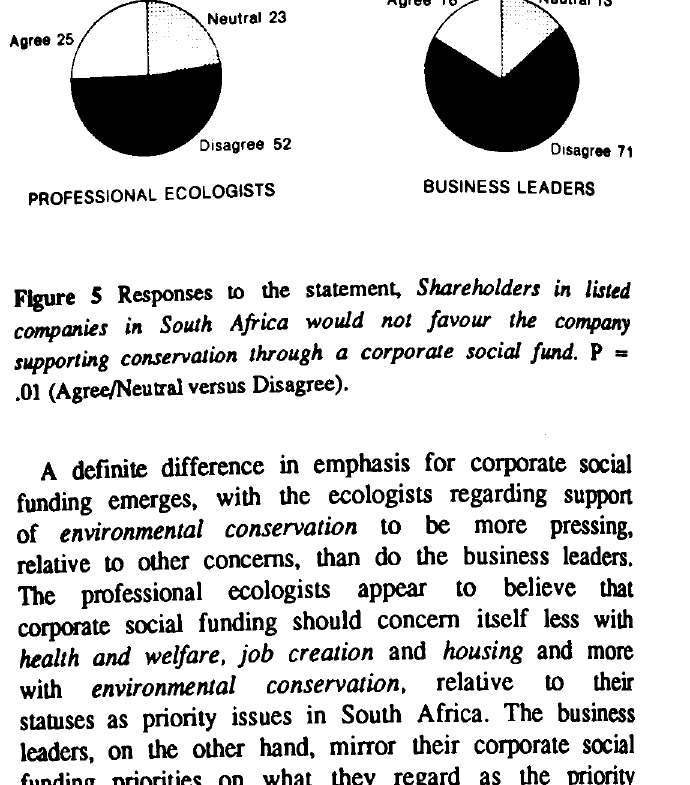
Figure s Responses to the statement, Shareholders in listed companies in SouJh Africa would not favour . the company supporting conservation through a corporaJe social Jund. P = .Ol (Agree/Neutral versus